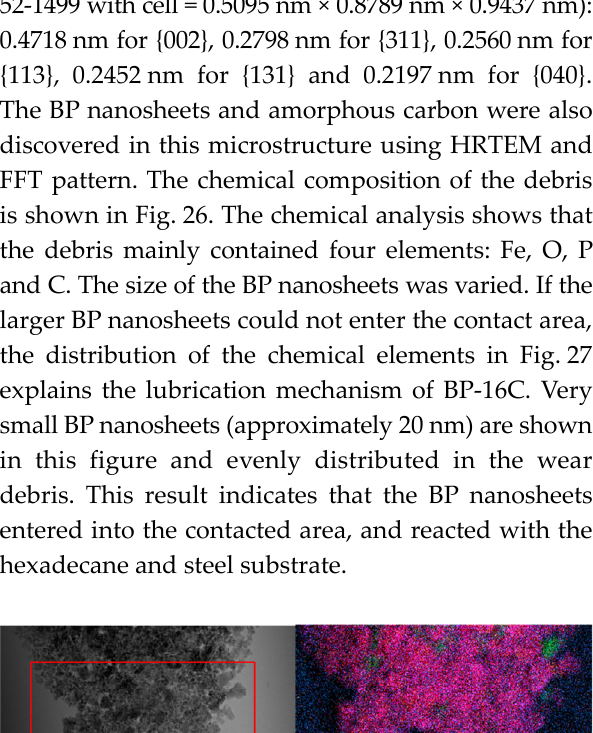
Figs. 28(b) − 28(f) illustrate the full spectrum and curve- fitted XPS spectra of C1s, Fe2p, O1s, and P2p on the wear scar of the disk lubricated with 10